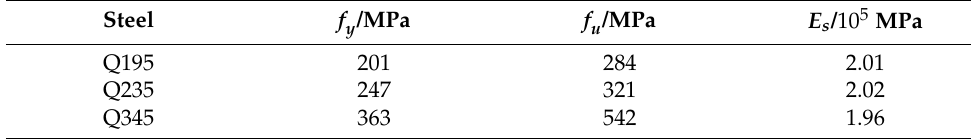
Table 1. Material properties of steel.